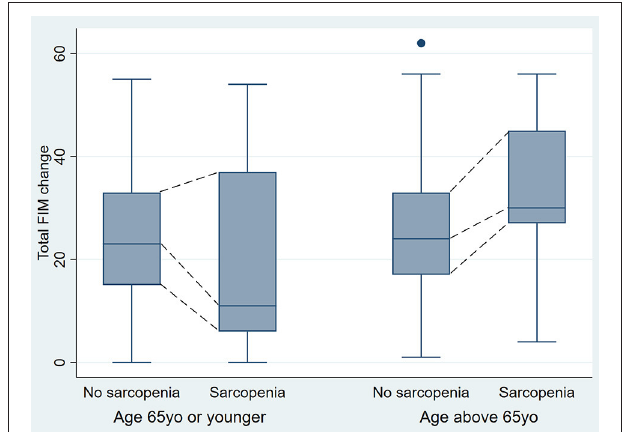
FIGURE 2 | Total FIM change in younger and older participants by sarcopenia status (One outlier value was removed from the Figure for ease of interpretation, but was still included in the